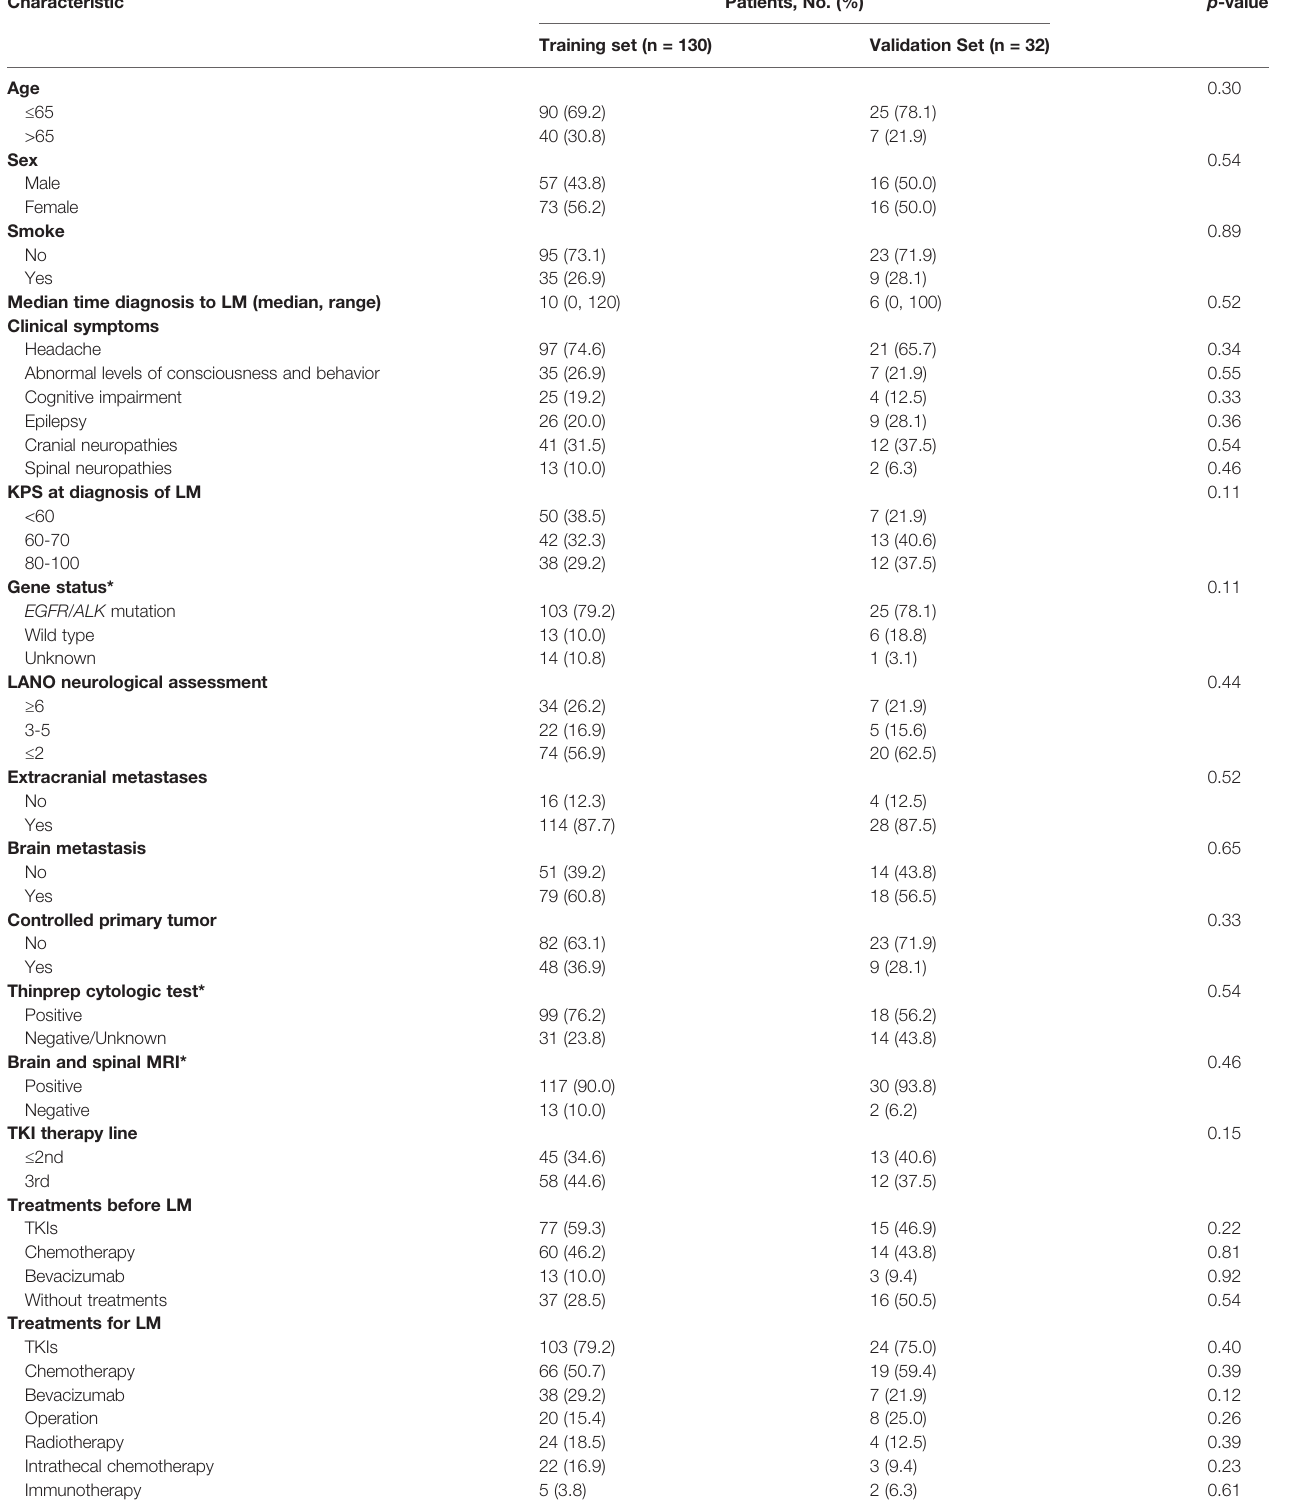
TABLE 1 | Demographic and clinical characteristics of the 162 lung adenocarcinoma patients with LM.